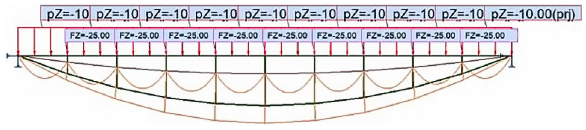
Figure 7. The case when the load is distributed